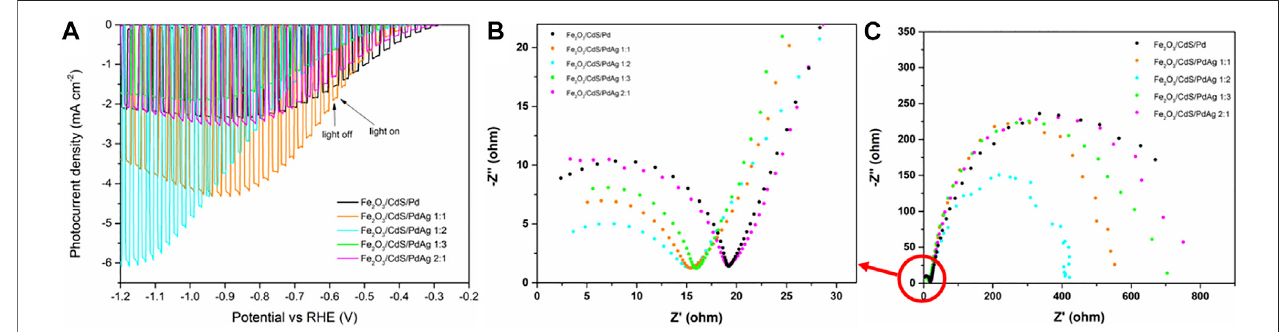
FIGURE 2 | (A) Cathodic linear sweep voltammetry under chopped illumination; (B) and (C) electrochemical impedance spectroscopy (EIS) of samples with different Pd:Ag